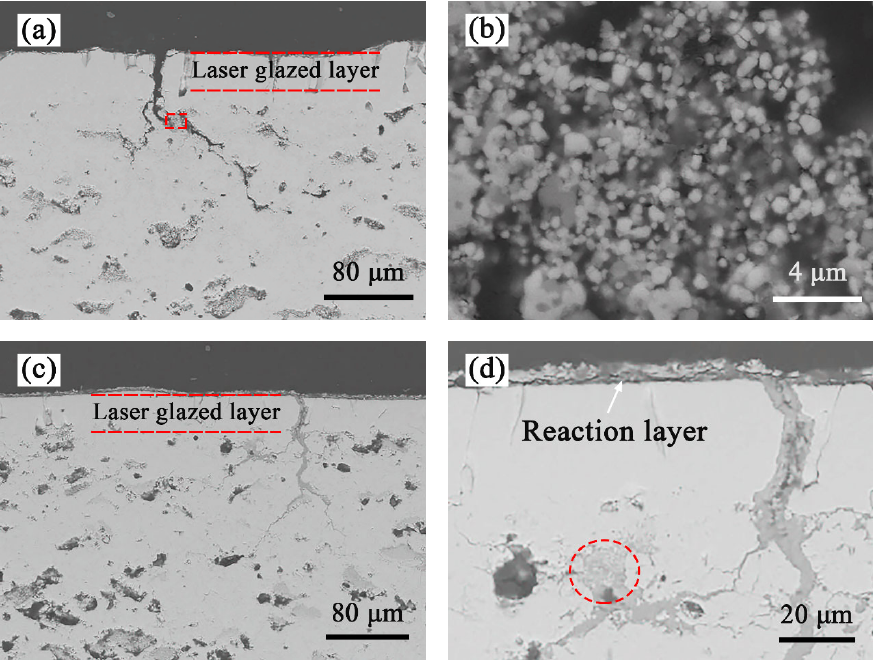
Fig. 10 Cross-sectional images of the laser glazed YSZ coatings after hot corrosion at (a, b) 700 ℃ and (c, d) 1000 ℃